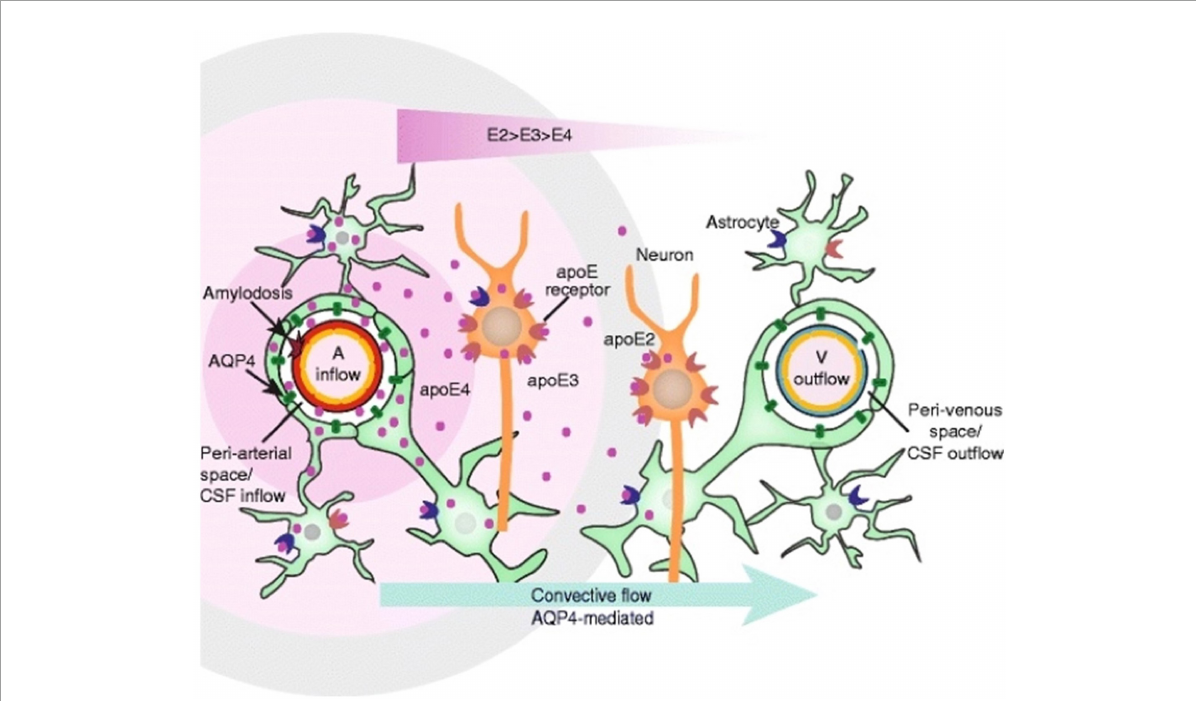
FIGURE4 Apolipoprotein (APOE) distribution in the glymphatic system. This schematic depicts the convective flow that occurs around an artery and toward the venous space. APOE is responsible for lipid transport and repair in the brain (Liu et al., 2013). APOE is delivered around the arteries, and density depends on the alleles present, with APOE4 having the greatest density near the artery (A) (Achariyar et al., 2016). Figure from Achariyar et al. (2016).